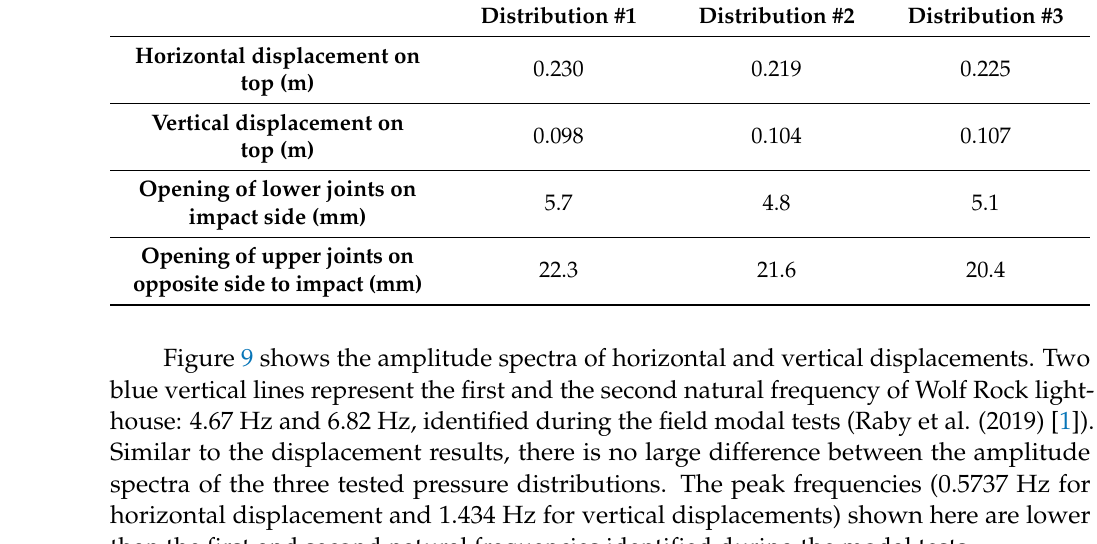
Table 1. Maximum response values for the three pressure profiles.